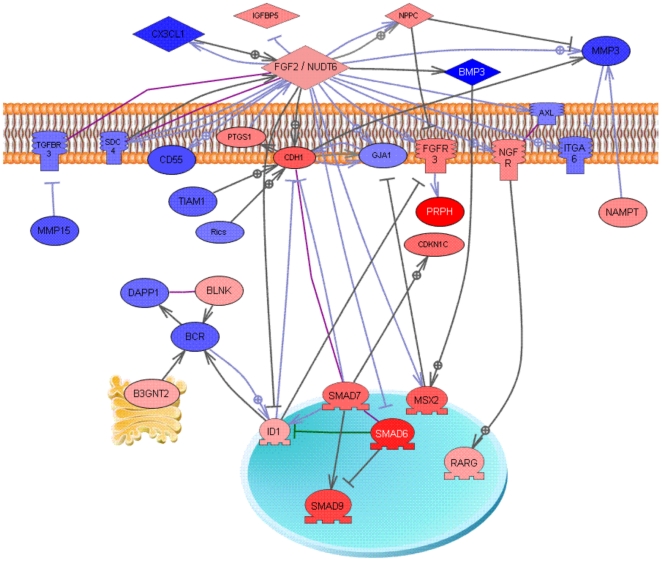
Gene network with direct connection scheme for AMH treated P0-ovary differentially expressed genes.Only 31 genes directly connected from the list of 274 are shown according to their location in the cell (on membrane, in Golgi apparatus, nucleus, cytoplasm or outside the cell), the rest of genes are not connected and not shown. Node shapes code: oval and circle – protein; diamond – ligand; circle/oval on tripod platform – transcription factor; ice cream cone – receptor. Red color represents up-regulated genes, blue color – down-regulated genes; arrows with plus sign show positive regulation/activation, arrows with minus sign – negative regulation/inhibition; grey arrows represent regulation, lilac - expression, and purple – binding.